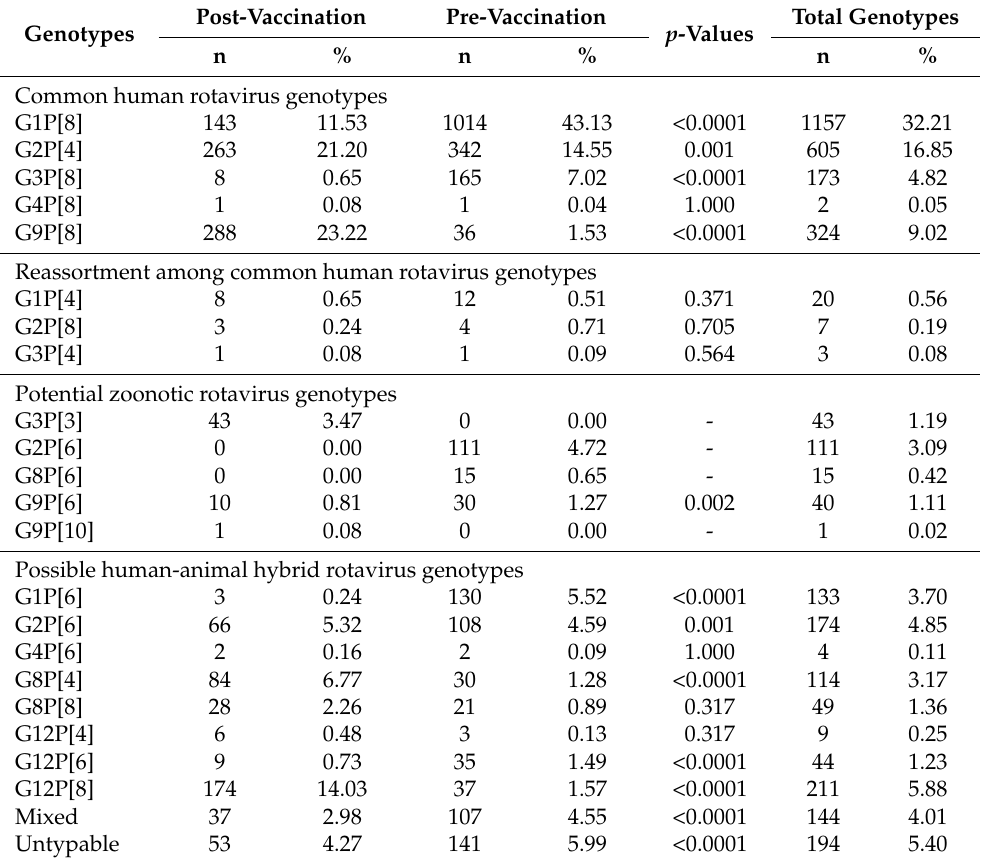
Table 2. Circulating rotavirus genotype G/P combinations in South Africa grouped by analogy to those of Iturriza G ó mara